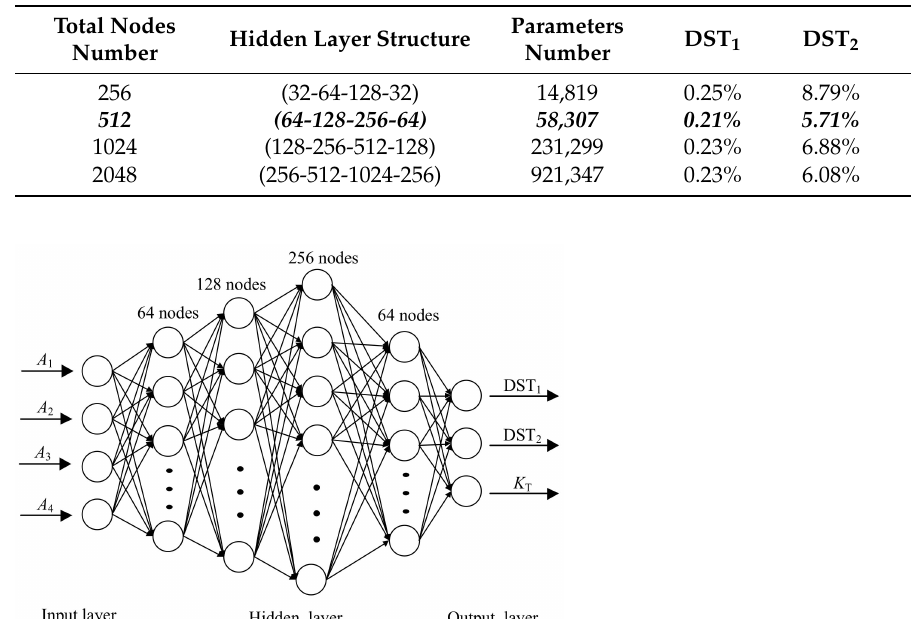
Table 2. Predictive error of different hidden-layer widths of the outputs.